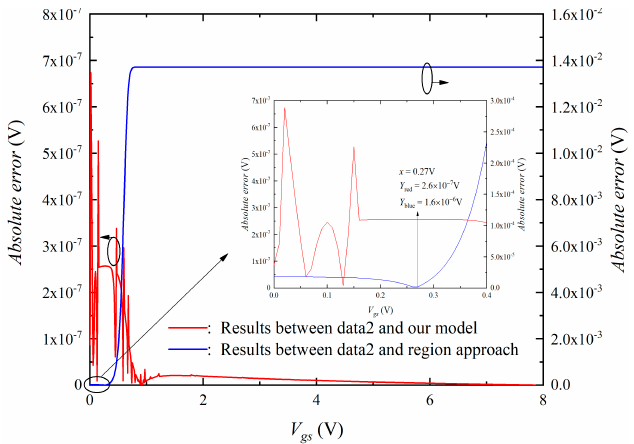
Figure 7. Absolute errors of surface potential results between our model, regional approach and numerical results using data2.